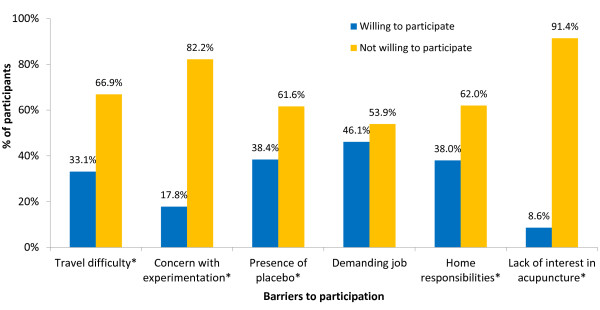
Barriers to participation differ by willingness to participate. *P < 0.001 by chi square analyses.